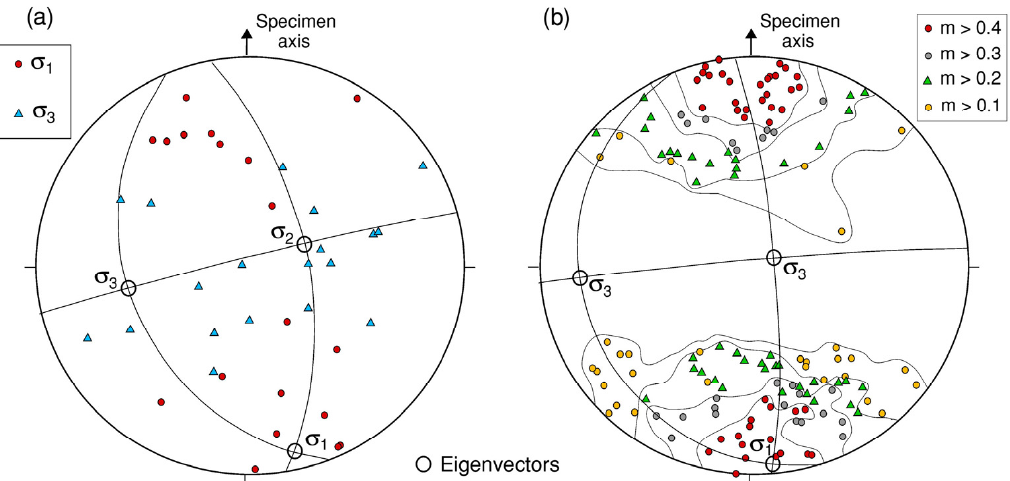
Figure 8. ( a ) Upper hemisphere, equal angle projection of orientations of σ 1 , σ 2 and σ 3 directions from analysis of 19 grains containing wide twins that were measured during EBSD scans. The three orthogonal eigenvectors shown correspond to the orientations of the estimated principal stress directions; ( b ) Upper hemisphere, equal angle projection of orientations of σ 1 directions from analysis of the 164 grains containing new twin lamellae that could not be measured in the EBSD analysis because they were too thin to be detected. Instead, the twin plane orientations were established by analysis of the traces of the twin lamellae on the specimen surface together with the host grain orientations. The data are grouped according to the value of the Schmid factors resolved along the slip directions on the twin planes. The contours are not density contours but lines separating grains with progressively higher Schmid factors. The best estimate of σ 1 lies in the group of points for which the Schmid factor exceeds 0.4, and it fits well with the known orientation of σ 1 applied to the test piece. Eigenvectors for the clustered data define the orientations of the principal stresses. σ 2 is taken to be equal to σ 3